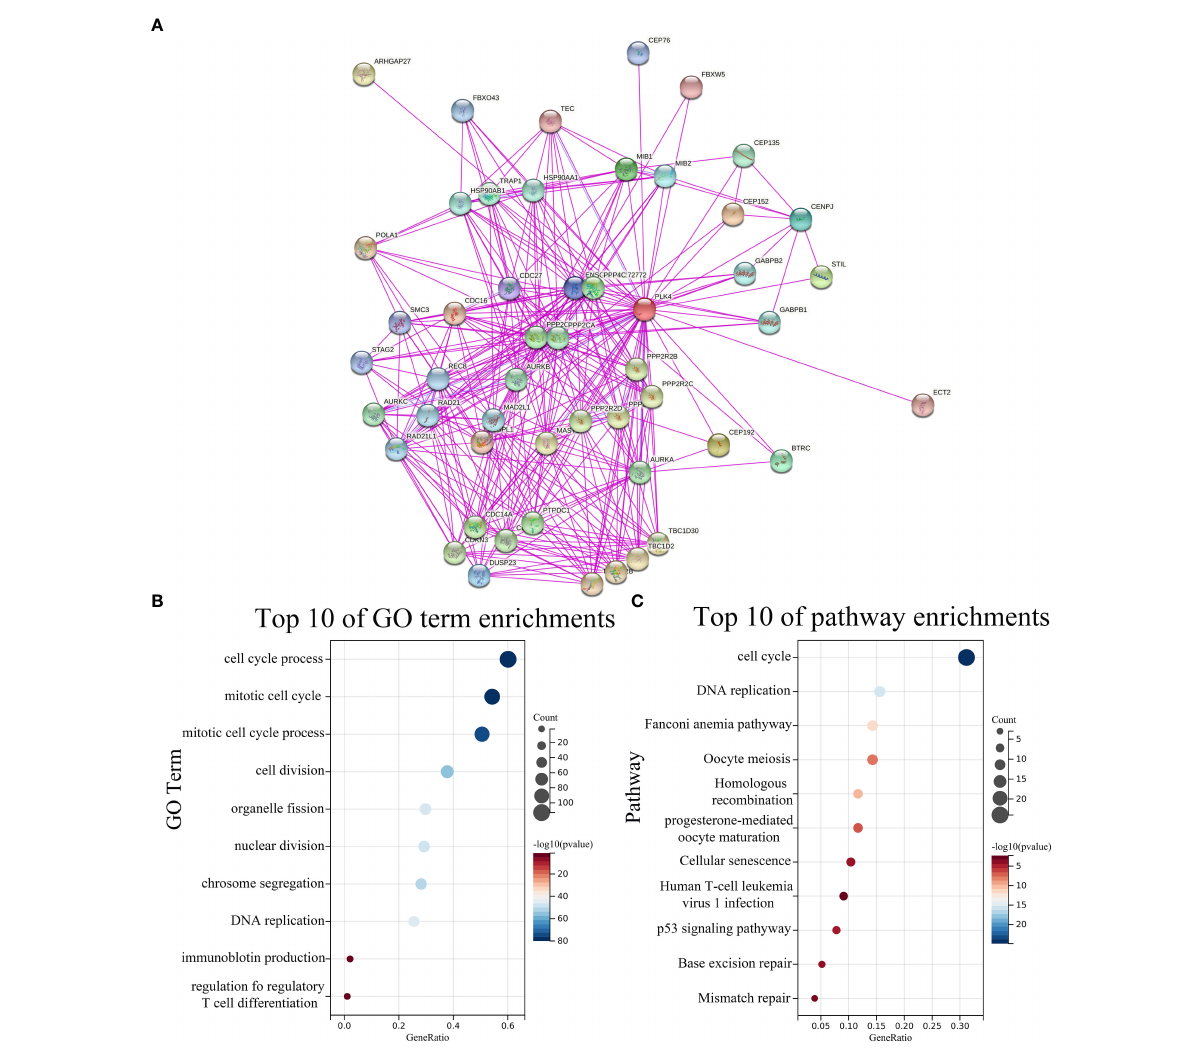
FIGURE 5 PLK4-related genes enrichment analysis. (A) PLK4-binding proteins obtained using the STRING tool. Signi fi cantly enriched GO annotations (B) and KEGG pathways (C) of 100 genes positively associated with PLK4 expression in all TCGA